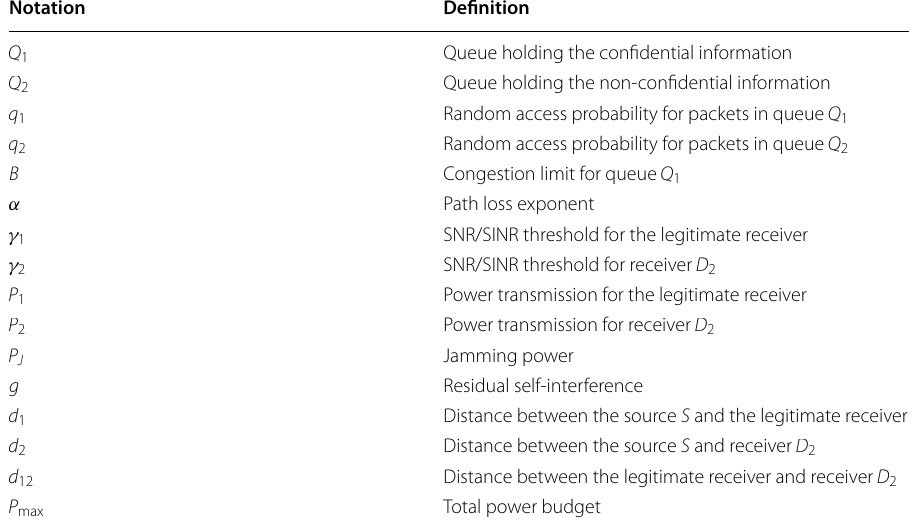
Table 1 List of